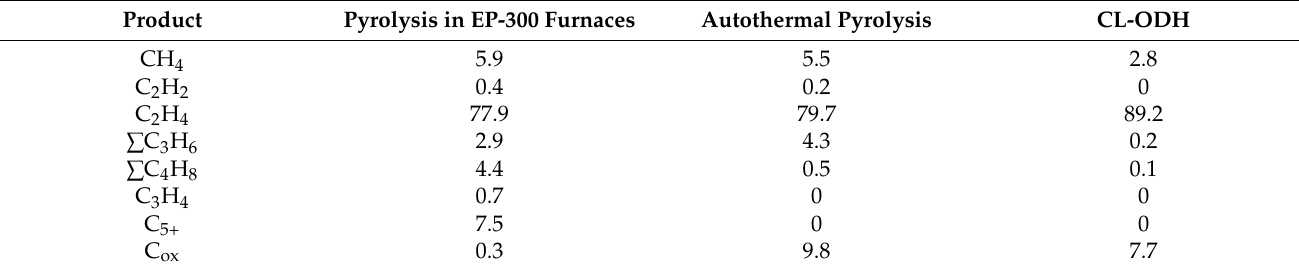
Table 7. Selectivity towards light products of different technology compared to CL-ODH process (%) .